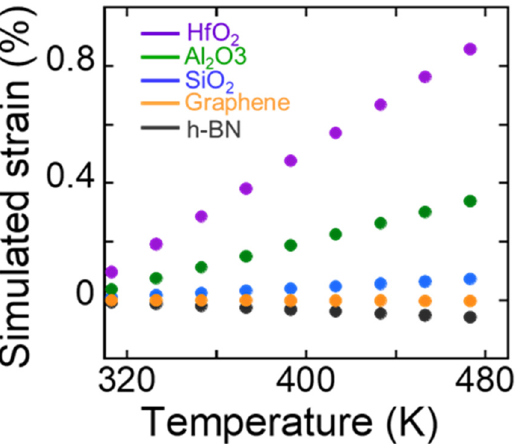
Figure 6. Simulated strain (%) as a function of temperature for five interfacial layers (HfO 2 , Al 2 O 3 , SiO 2 , graphene, and h-BN) with different temperatures ranging from 300 K to 473 K.